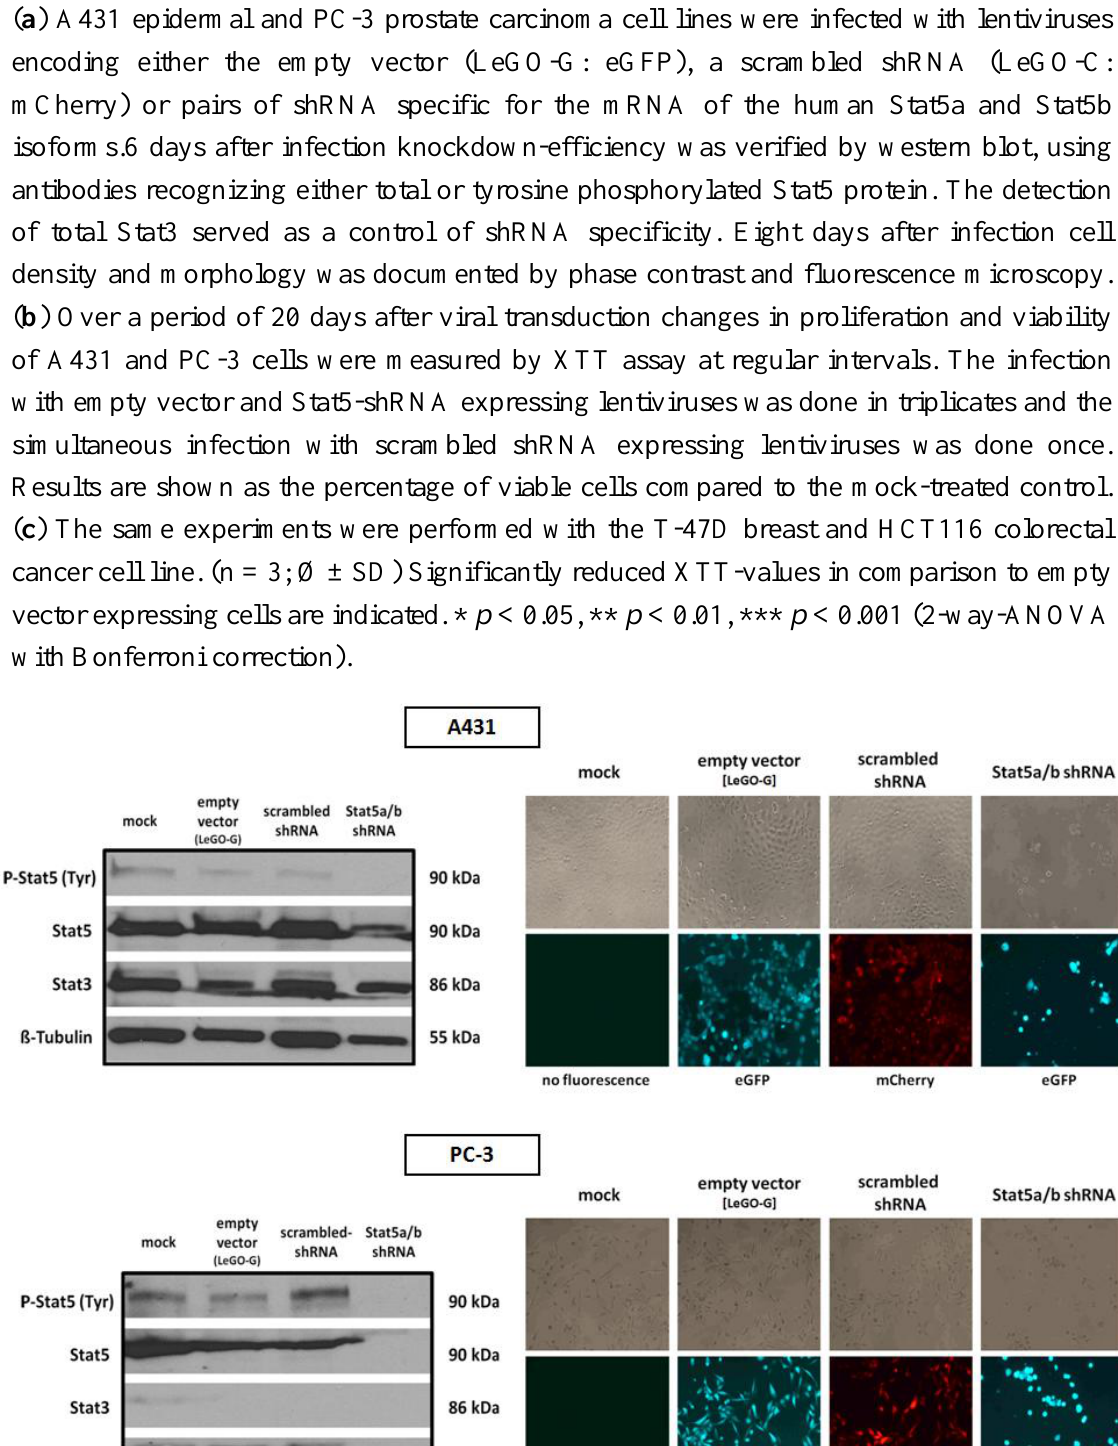
Figure 1. Infection with a lentivirus gene transfer vector encoding Stat5-directed shRNA reduces Stat5 expression and suppresses the growth and viability of human tumor